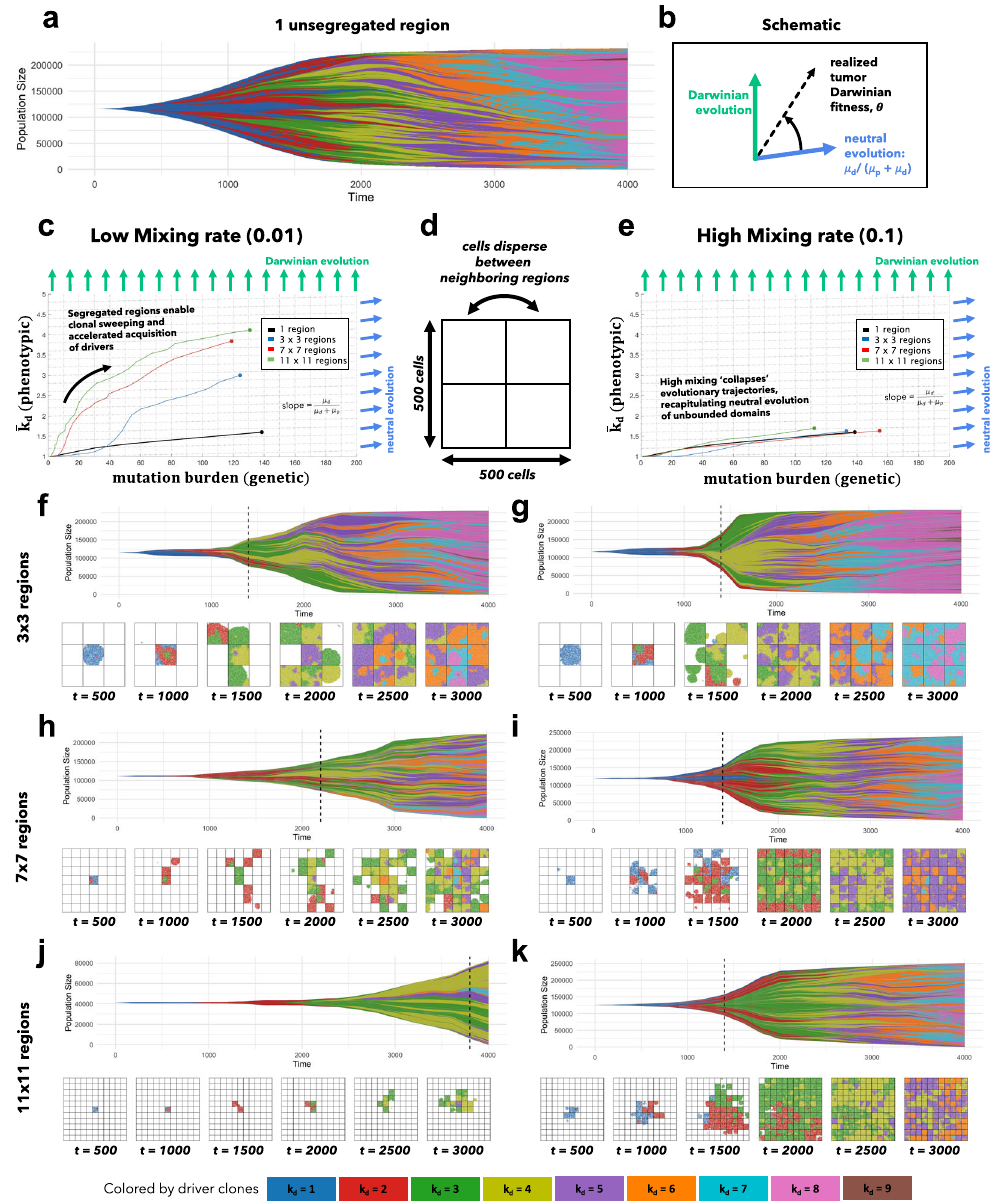
Fig. 2 Spatial segregation with cell mixing accelerates evolution. a A Muller plot of tumor evolution represents genotypes color-coded by driver ( k d ) value. The horizontal axis is time (cell generations), with height corresponding to genotype frequency. Descendant genotypes are shown emerging from inside their parents. b A tumor ’ s “ realized fi tness ” can be quanti fi ed as the time-varying slope of the evolutionary trajectory. c Tumors evolve on the genetic (mutation burden; x-axis) and phenotypic (average drivers; y-axis) axes. For low mixing, smaller regions impose higher selection pressure, accelerating the acquisition of drivers in the population (vertical axis). Simulations are run to identical tumor size (25% of the total domain). d The domain is segregated into regions where cells disperse are allowed to mix between segregated regions at a low rate (0.01; c ; left column) or high rate (0.1; e right column). e As mixing increases, tumor evolution “ collapses ” back onto the unsegregated single region case shown in black in ( b ). Snapshots are shown every 500 generations. Simulations repeated for 3 by 3 regions ( f , g ), 7 by 7 regions ( h , i ), and 11 by 11 regions ( j , k ). Parameters: T p = 5 ⋅ 10 6 , T d = 700, s d = 0.1, s p = 10 − 3 , μ = 10 − 8 . See attached video